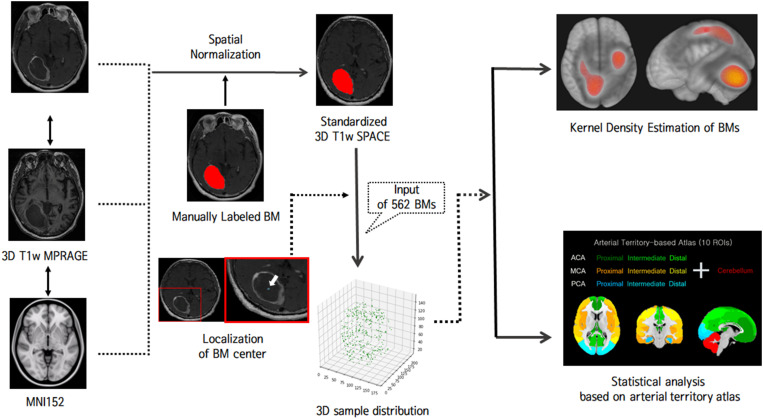
Schematic illustration of the flow of image analysis.